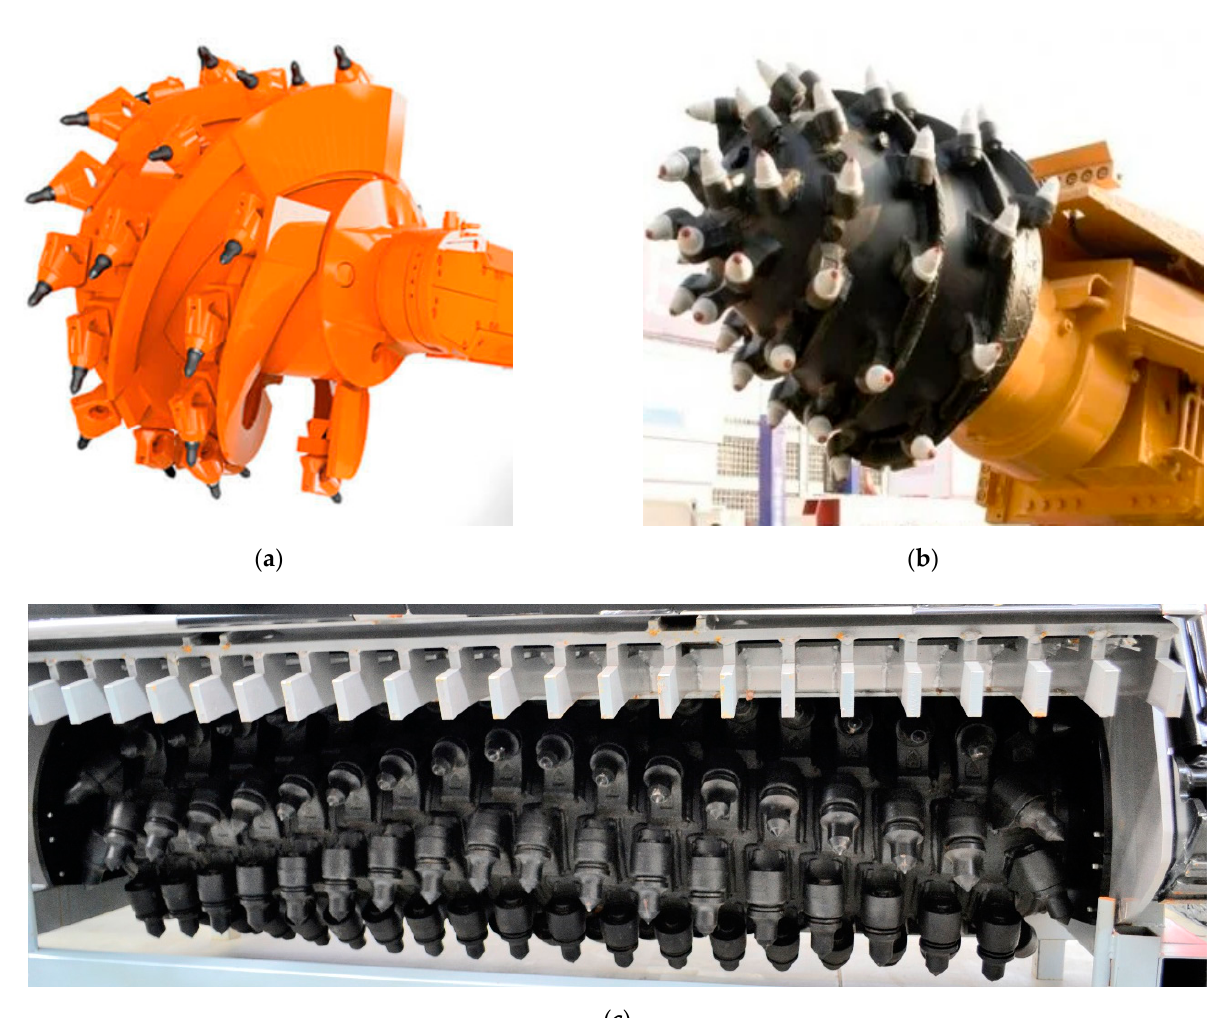
Figure 1. Cutting heads of: ( a ) a longwall shearer; ( b ) a roadheader; and ( c ) a road milling machine [13,14,20].